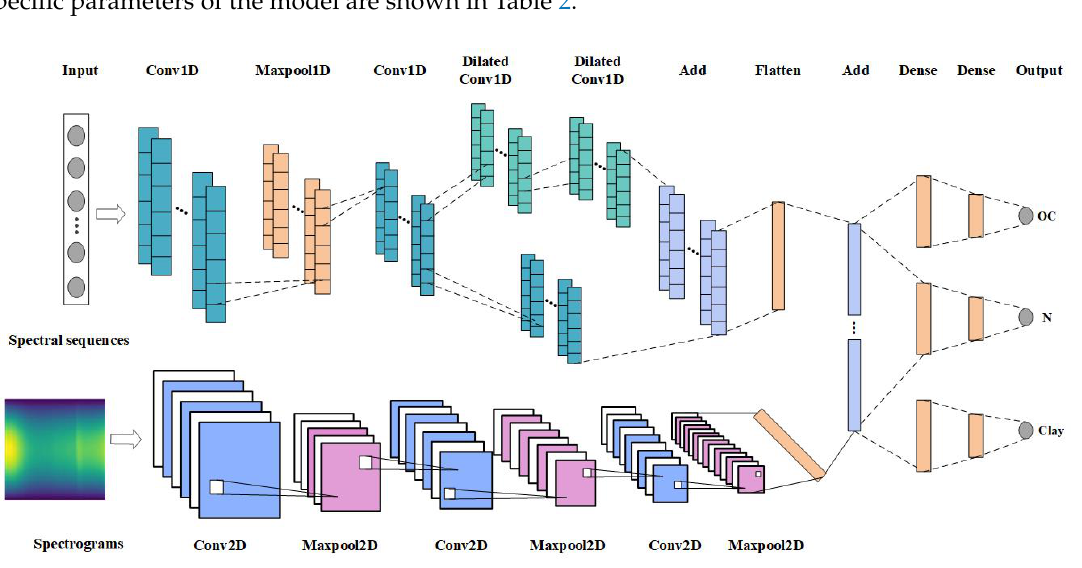
Figure 5. The Multi_CNN network structure. Table 2. Multi_CNN network specific parameter